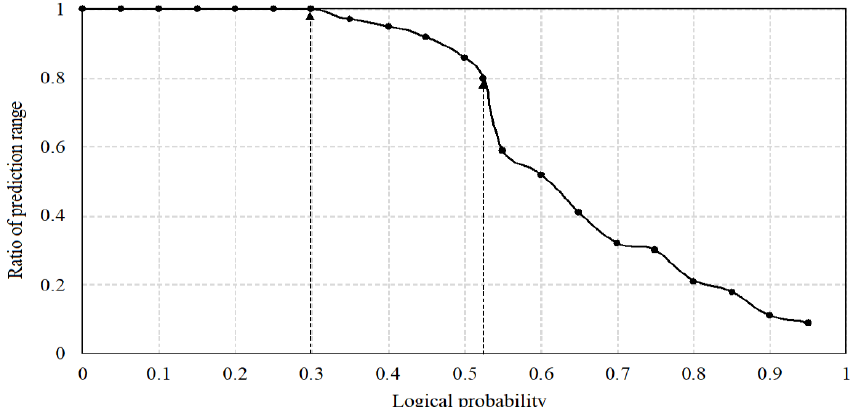
Figure 20. Logical probability versus the ratio of prediction volume to orebody occupied volume.